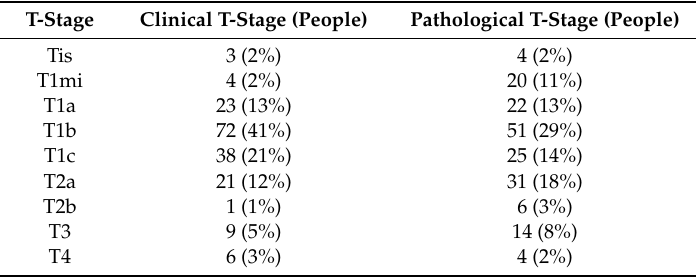
Table 2. Distribution of cases by T-stage.